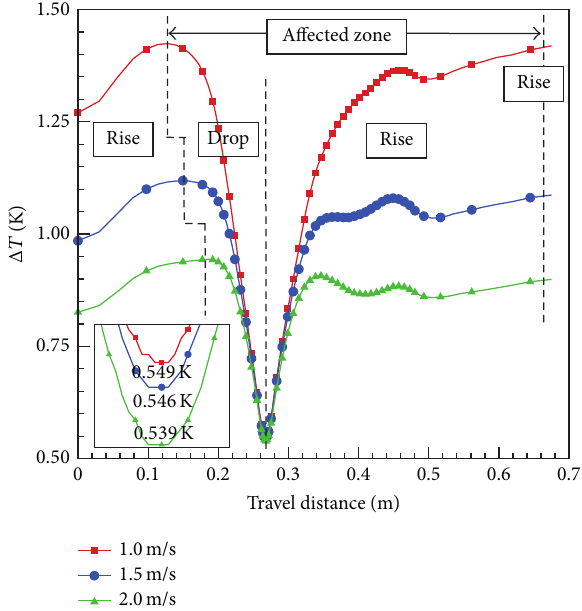
Figure 5: Effect of inlet velocity on temperature drop along the extrados of